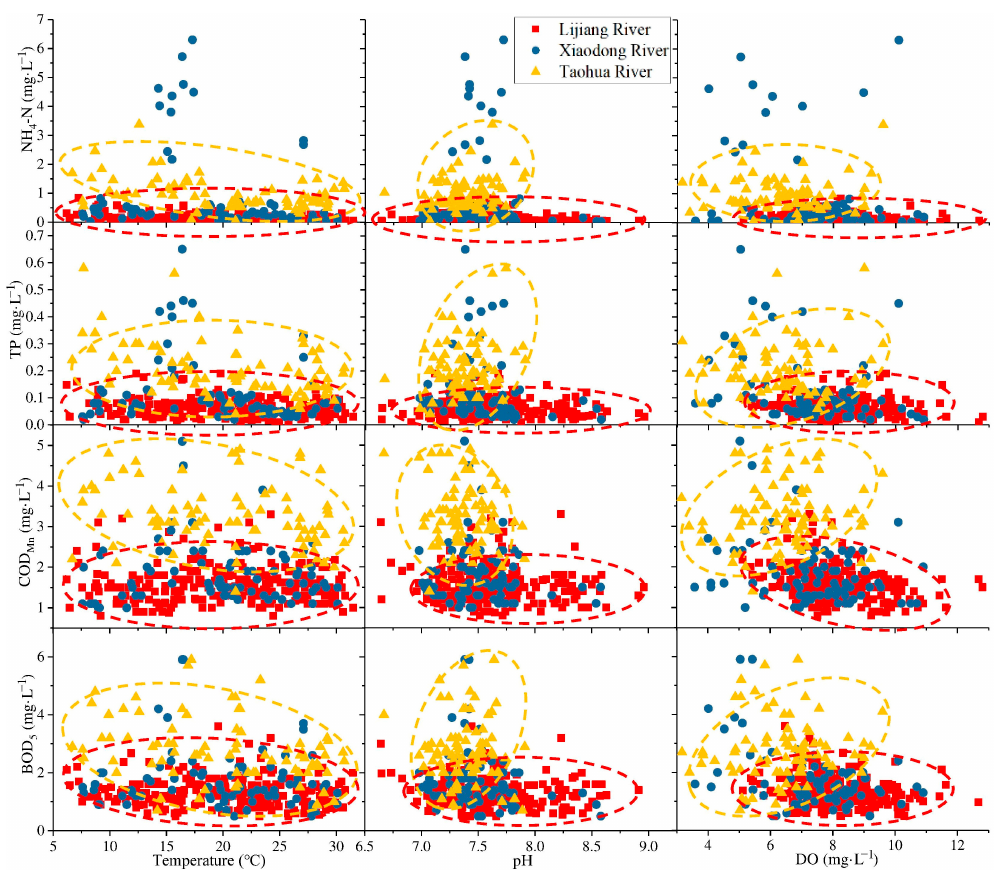
Figure 6. Differences in the impact of different river environmental factors on water quality indicators.